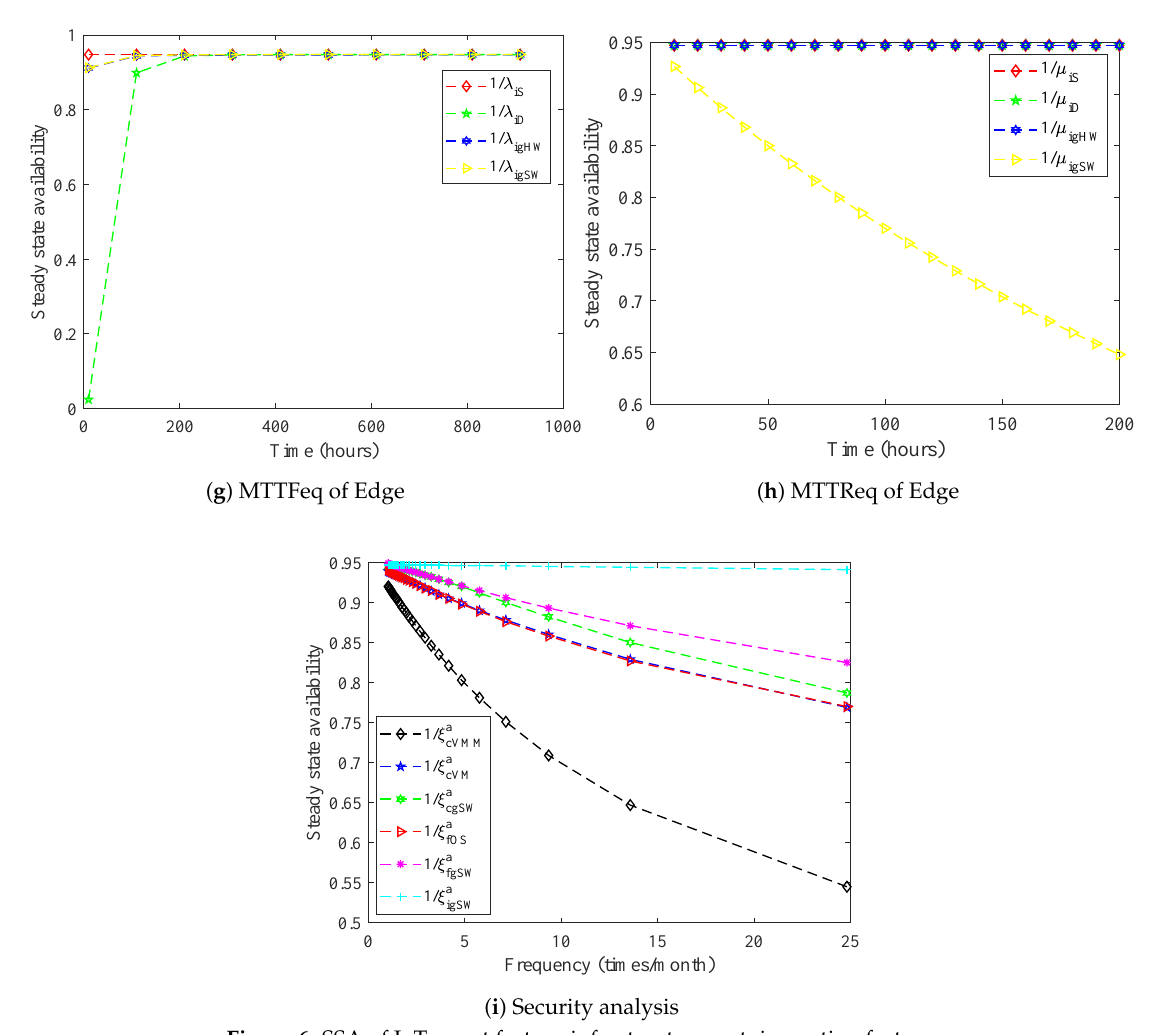
Figure 6. SSA of IoT smart factory infrastructure wrt. impacting